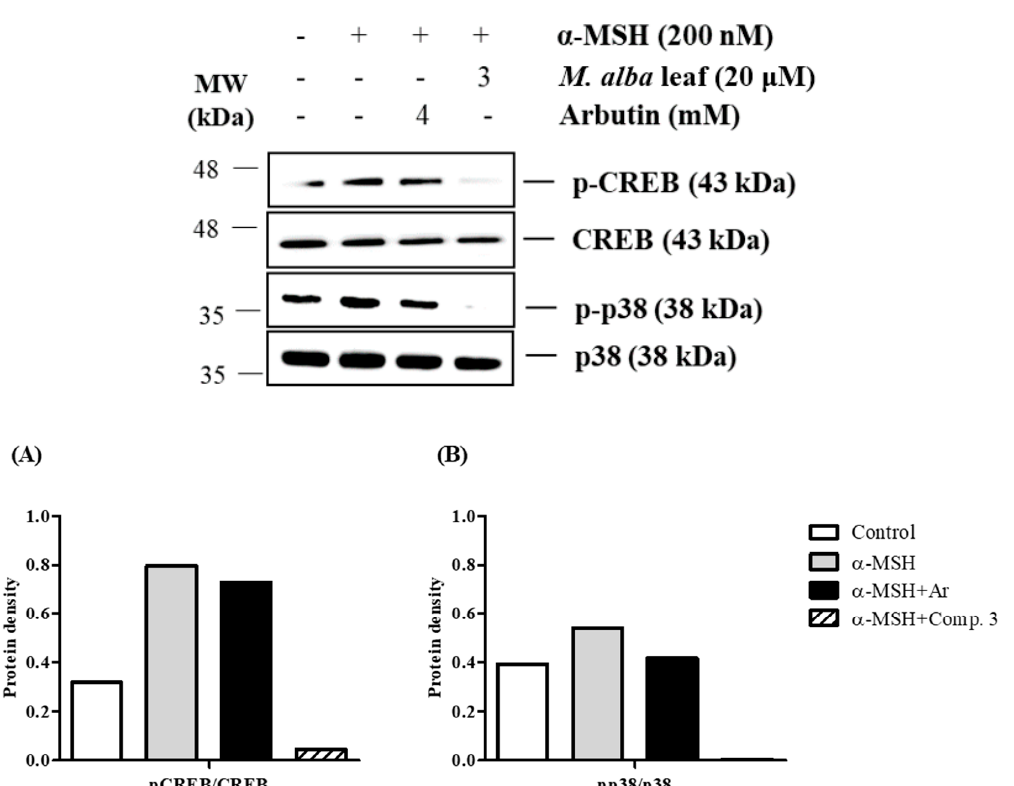
Figure 6. Effects of M. alba leaves on the phosphorylation of the cAMP-responsive element-binding protein (CREB) and p38 in α -MSH-induced B16-F10 cell; B16-F10 cells were pretreated with test samples for 2 h and α -MSH was added to the cells for 24 h. Total protein was used as the control protein. The protein levels of pCREB, CREB, pp38, p38 were detected by Western blot analysis. Compound 3 significantly reduced the expression of pCREB and pp38 in α -MSH-induced B16-F10 cells. Arbutin, a positive control drug, also blocked the melanogenesis. The protein level of ( A ) pCREB and ( B ) pp38 were quantitated with Azure Spot software. pCREB and pp38 protein levels were normalized by the total protein of CREB or p38.